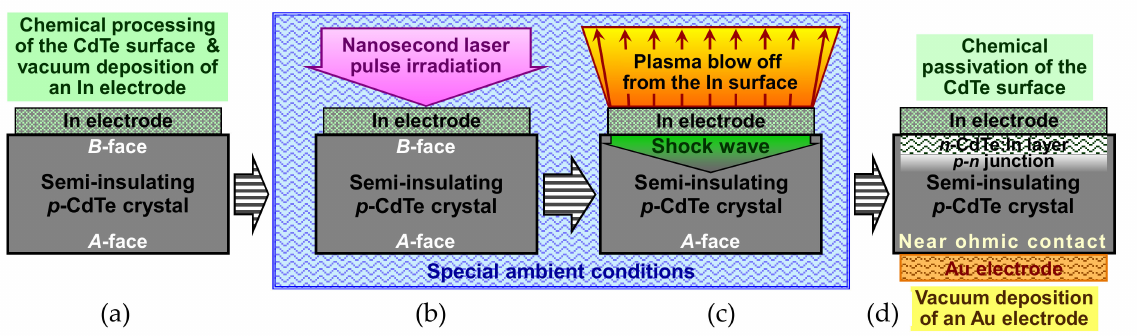
Figure 7. Schematic illustration of the fabrication procedures of In/CdTe/Au diode detectors using the laser irradiation technique: ( a ) chemical surface processing of the crystal and thermal vacuum deposition of an In electrode (dopant film) on the CdTe(111) B surface; ( b ) irradiation of the In/CdTe structure with nanosecond laser pulses; ( c ) laser-induced shock wave solid-phase doping of the p -CdTe surface region by In atoms (donors) and formation of a p-n junction; ( d ) chemical passivation of the crystal surfaces and thermal vacuum deposition of an Au electrode on the CdTe(111) A